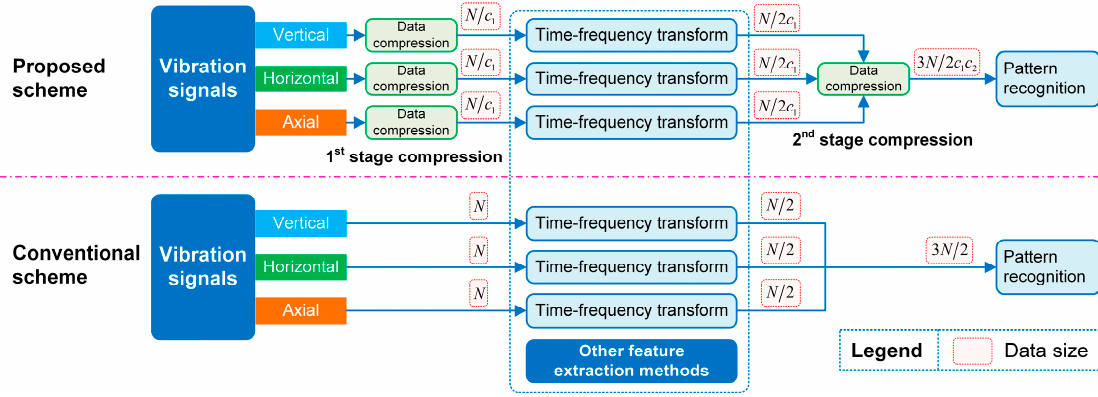
Figure 6. Data size